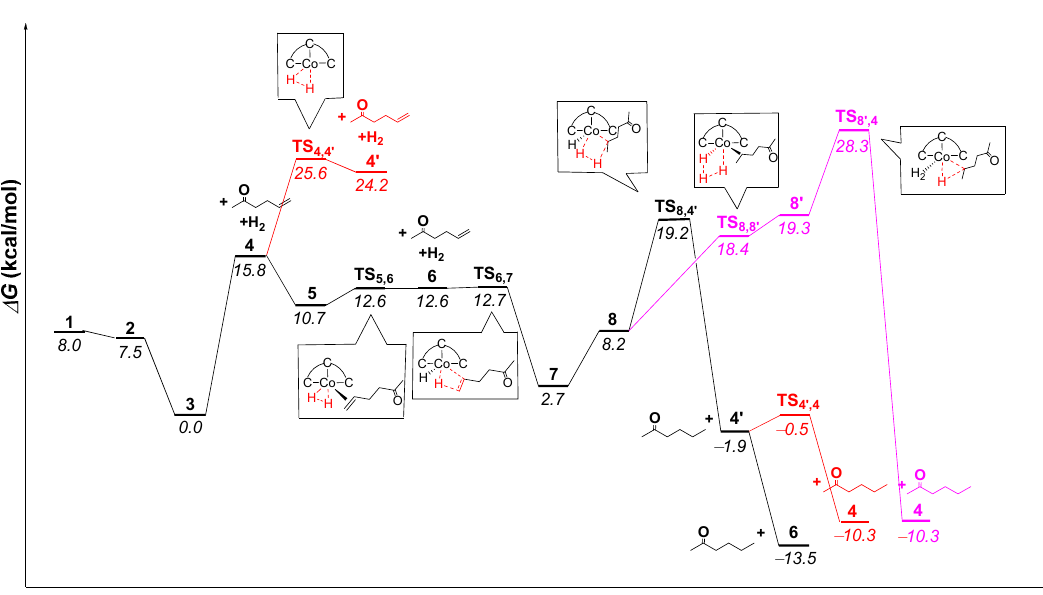
Figure 1. Free energy profile for the hydrogenation of hex-5-en-2-one to hexan-2-one catalyzed by ( Mes CCC)Co complexes.